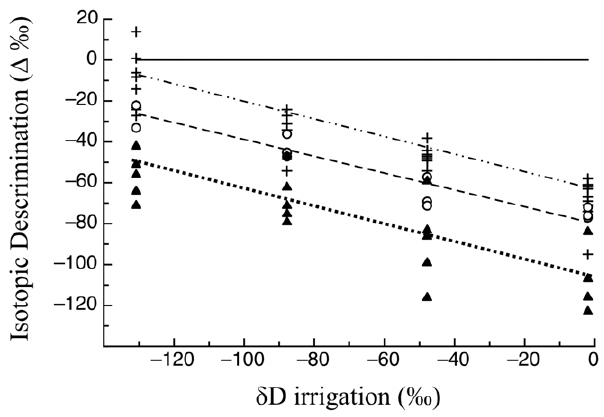
Figure 2. Isotopic discrimination factors varied with d D of irrigation. The discrimination factors from the deuterium signatures of plants (solid triangles, dotted line), caterpillars (plus ‘ + ’ signs, barred- dotted line), and moths (open circles, barred line) to that of irrigation water became more negative as the d D value of irrigation water increased. Note that the discrimination factors for plants, caterpillars and moths differed significantly from one another (Tukey’s test, p , 0.05). The horizontal reference line represents D D=0.